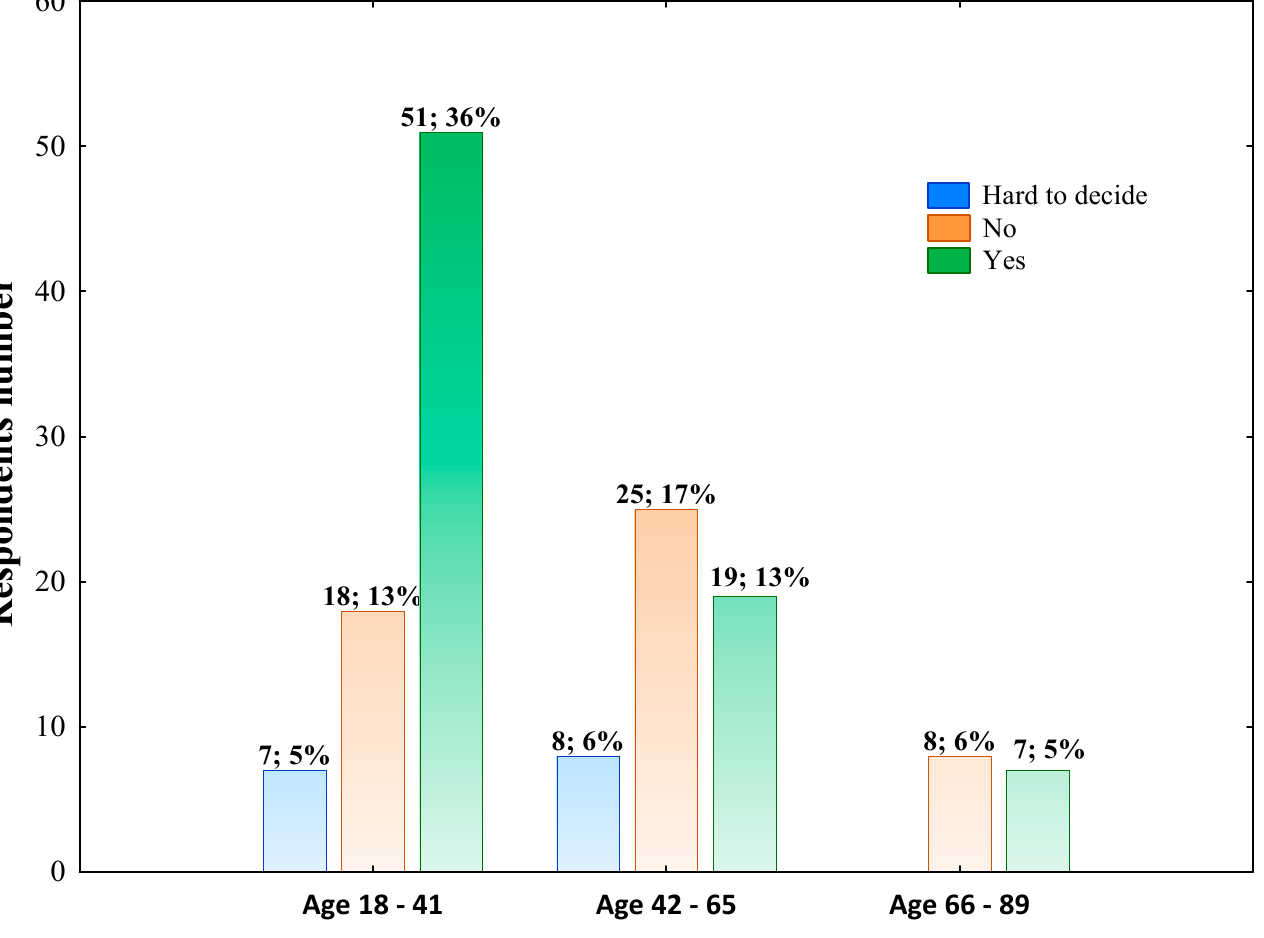
Figure 7. The change in daily lifestyle due to the COVID-19 pandemic across aged groups. The column description includes the respondents’ number aged in this range who chose such an answer, followed by the percentage of the total respondents. Data were analyzed using Pearson’s chi-squared test. Pearson’s χ 2 = 15.015; df = 4; p = 0.00467; n = 144.